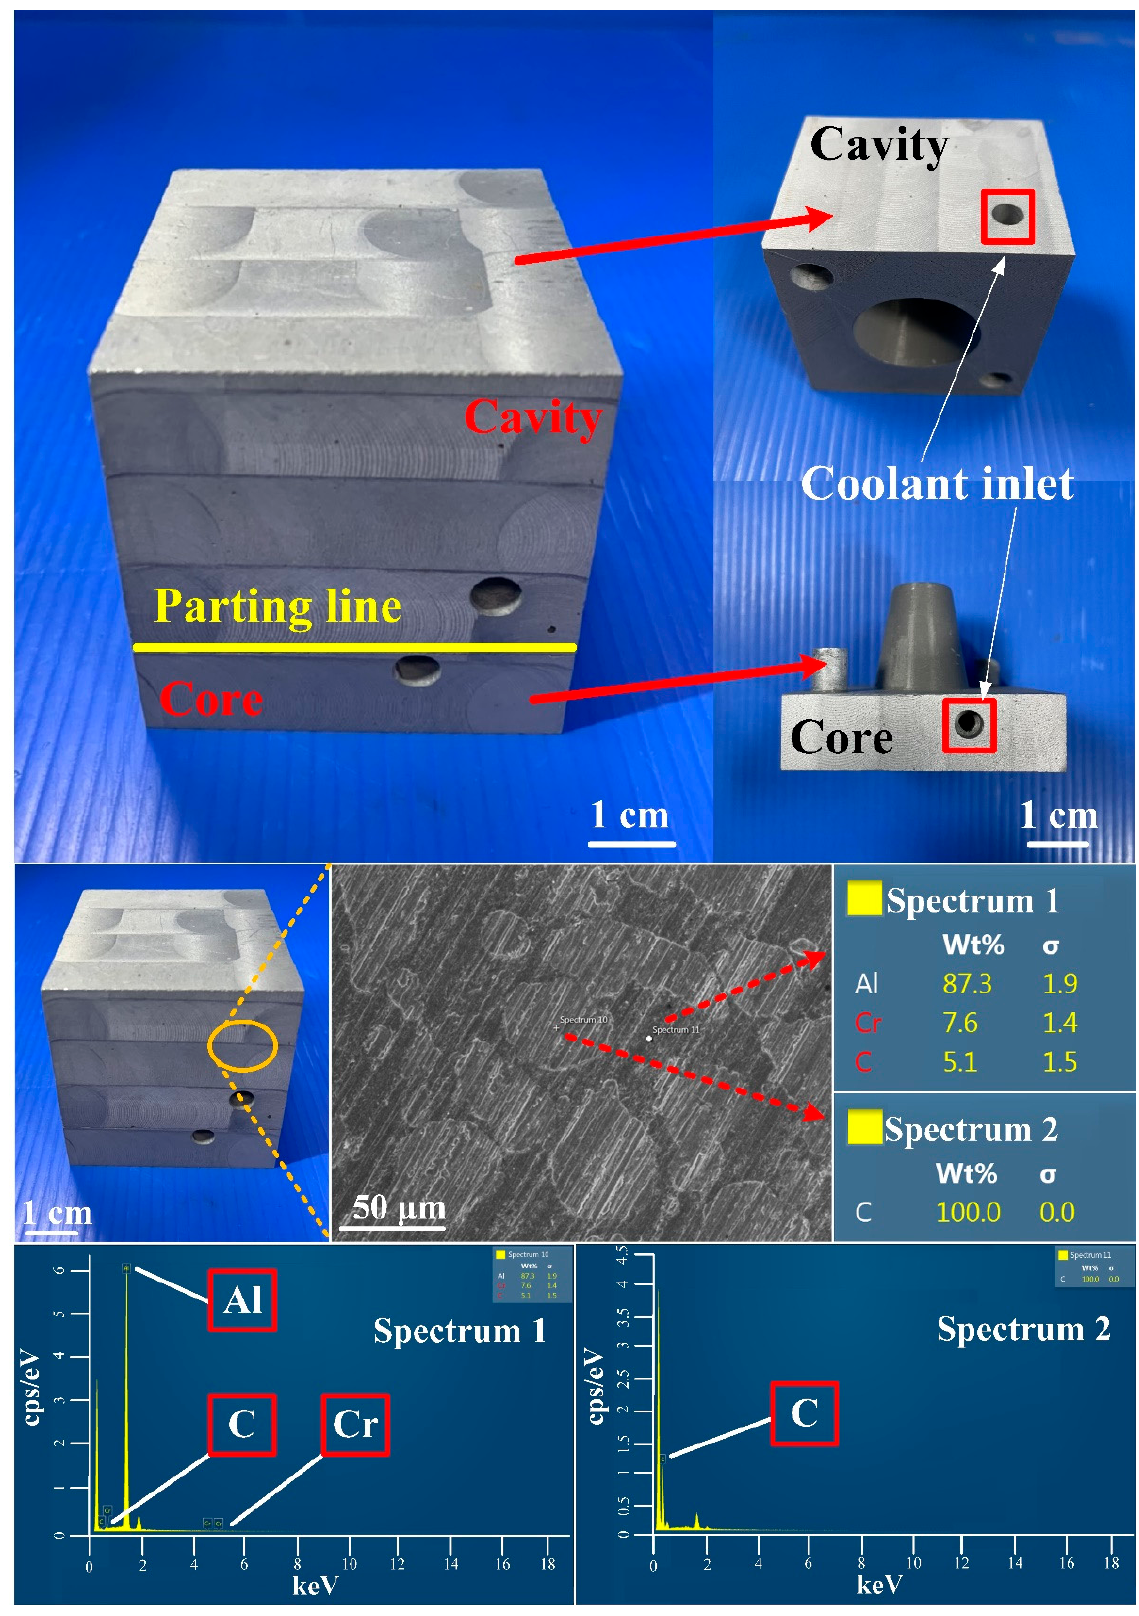
Figure 19. SEM micrographs and chemical composition of wax injection mold fabricated by epoxy resin added with 39 vol.% Al powder.